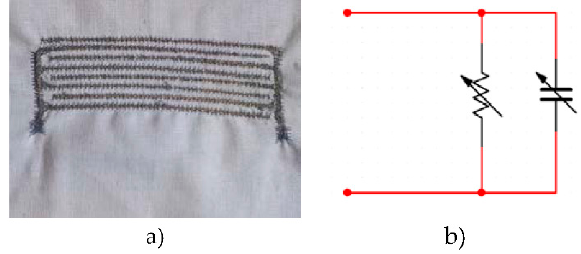
Figure 4. Proposed long sensor ( a ) physical implementation ( b ) Electrical